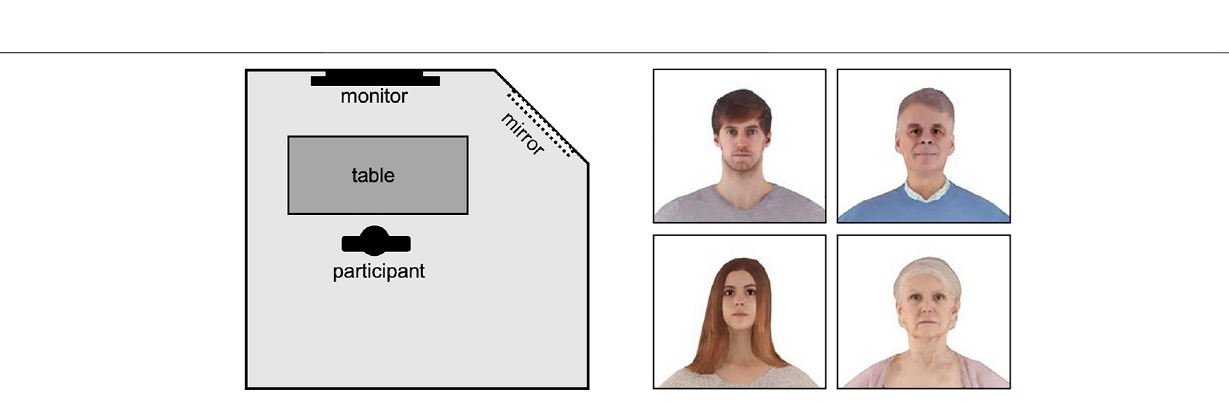
FIGURE 1 | Laboratory room and virtual simulation comparison. Note. See download link below for video demonstration. https://osf.io/rnz62/ fi les/osfstorage/624829a267553801c7625812/.